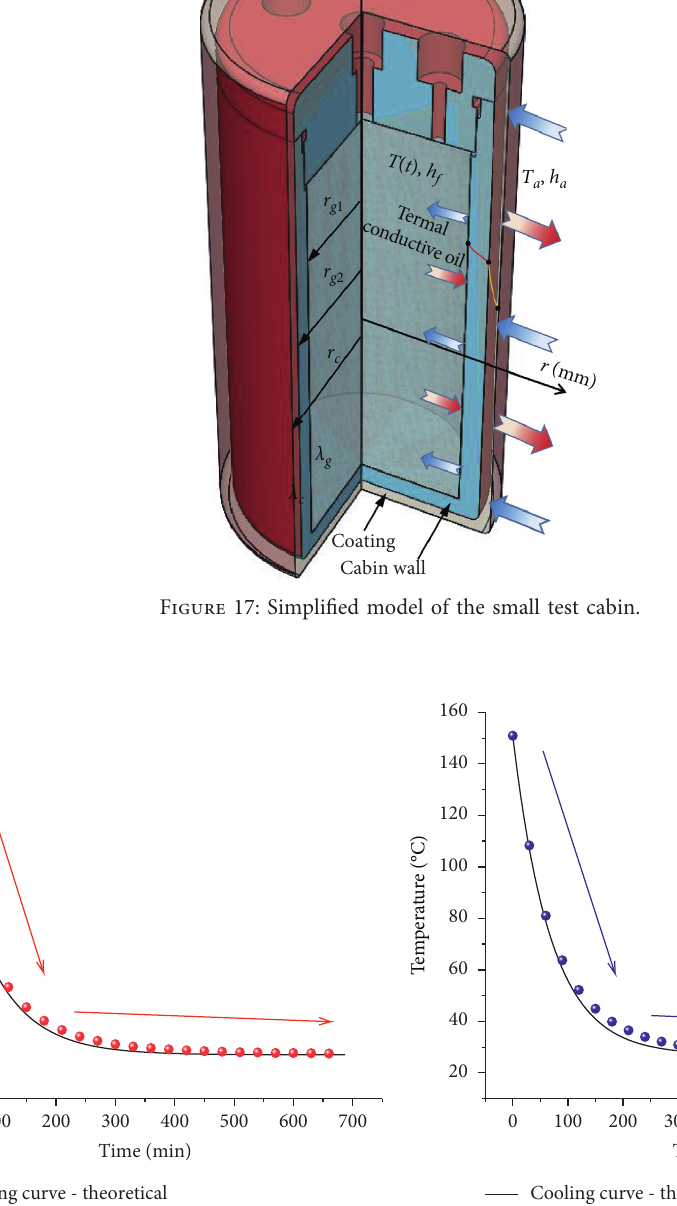
1 . (b) Results of the blank